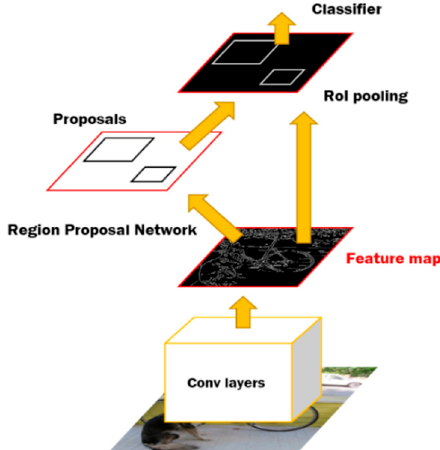
Figure 1. Block diagram of a faster regional convolutional neural network (R-CNN).